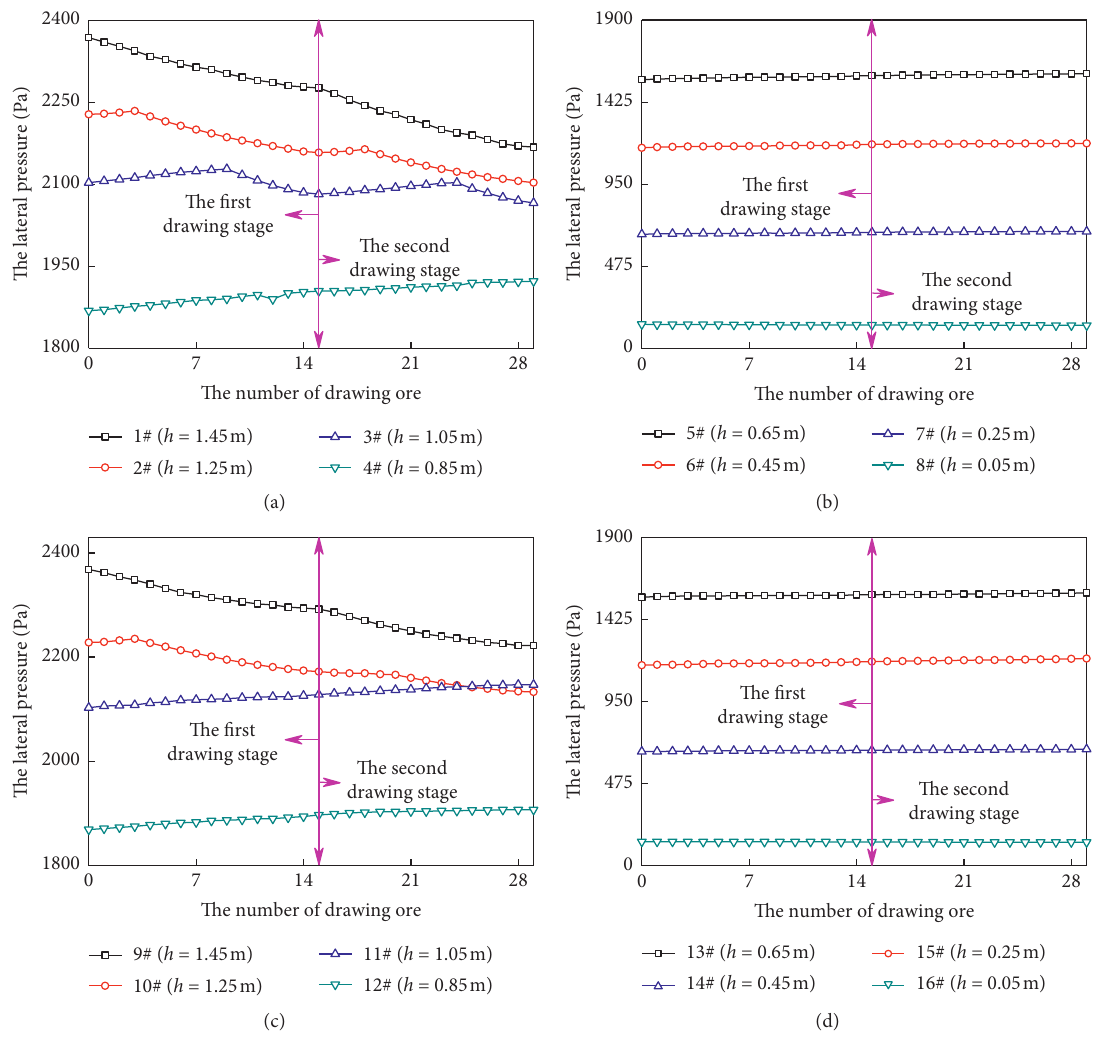
Figure 5: The relationship between the number of drawing ore and the values of lateral pressure with scheme